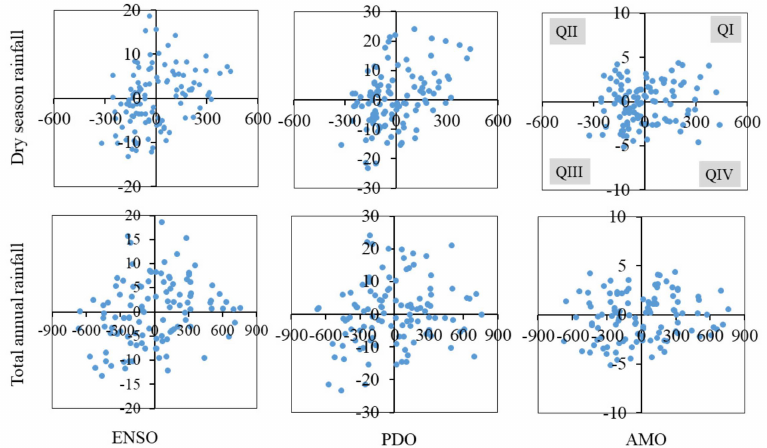
Figure 6. Quadrant-based correspondence test of total annual and dry season rainfall deviation to ENSO, PDO, and AMO. The x -axis refers to the rainfall deviation (mm) and the vertical axis refers to the cumulative SST anomaly ( ◦ C) of the respective